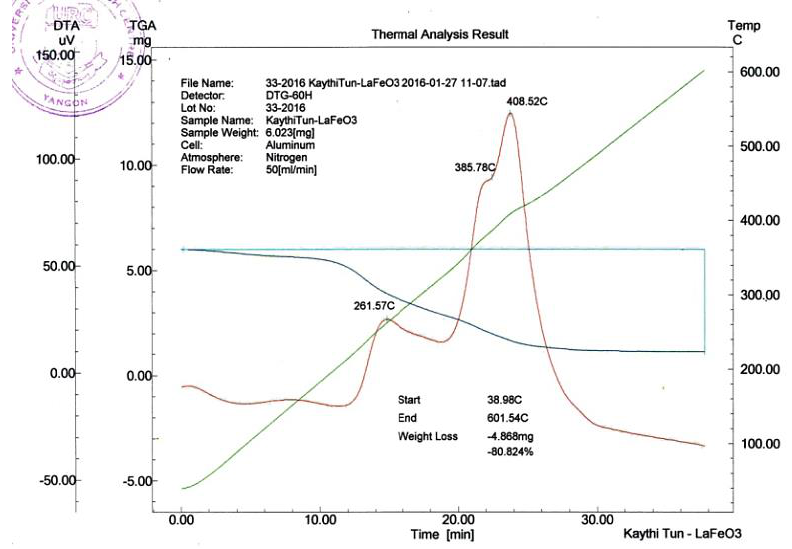
Figure 1. TG-DTA curves of the thermal decomposition of LaFeO 3 xero-gel